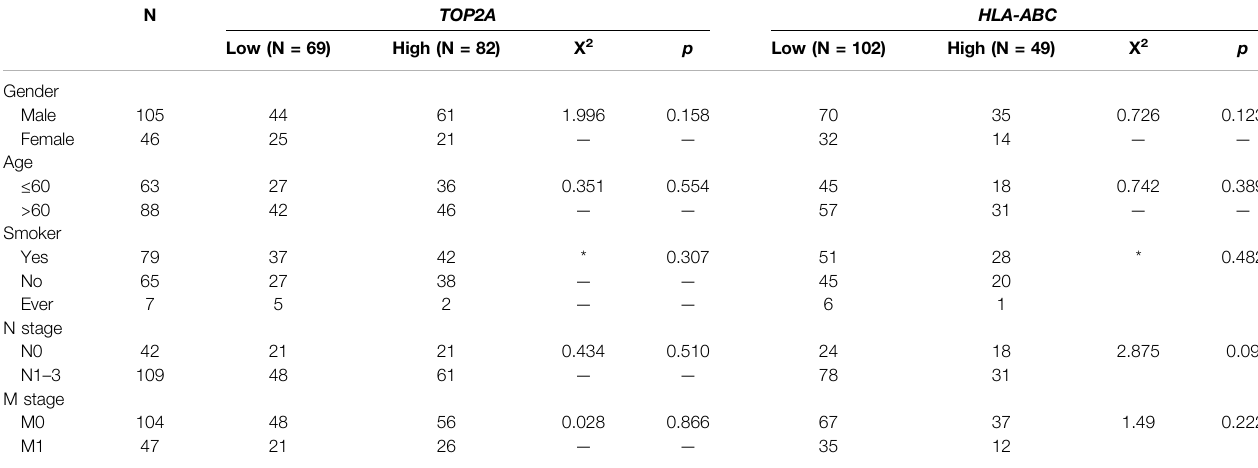
TABLE 4 | Correlations between TOP2A/HLA-ABC expression and clinicopathological characteristics of 151 patients with SCLC. N